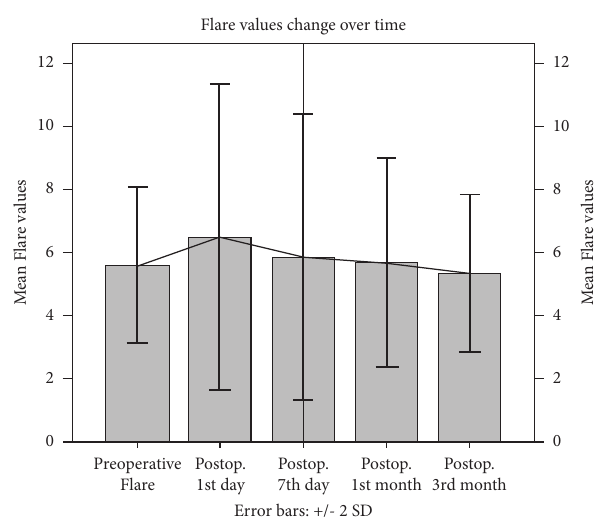
Figure 1: Change in flare values (photons/ms) over time. Table 2: Cross-comparison of the flare values, paired t -test ( p values).